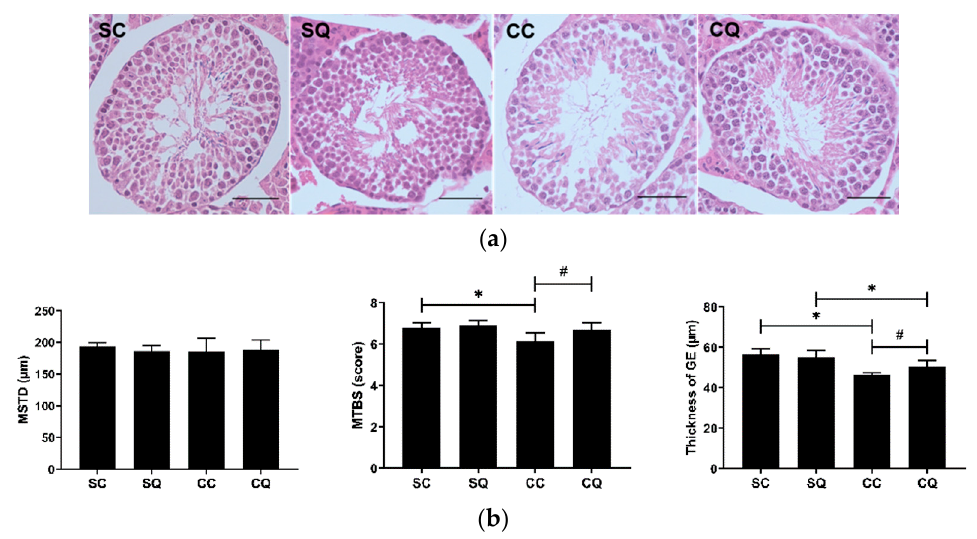
Figure 4. ( a ) Testicular morphology (scale bar: 50 µm), ( b ) mean seminiferous tubule diameter (MSTD), mean testicular biopsy score (MTBS) and thickness of the germinal epithelium (GE) in the sham surgery and CKD surgery mice treated with vehicle (corn oil) or CoQ10. SC: sham surgery mice with vehicle; SQ: sham surgery mice with CoQ10; CC: CKD surgery mice with vehicle; CQ: CKD surgery mice with CoQ10. Data are expressed as the mean ± SD ( n = 5–6 per group). * p < 0.05 denotes a significant difference between the sham surgery and CKD surgery groups (SC vs. CC and SQ vs. CQ); # p < 0.05 denotes a significant difference between the vehicle treatment and CoQ10 treatment groups (SC vs. SQ and CC vs. CQ). CoQ10, coenzyme Q10.